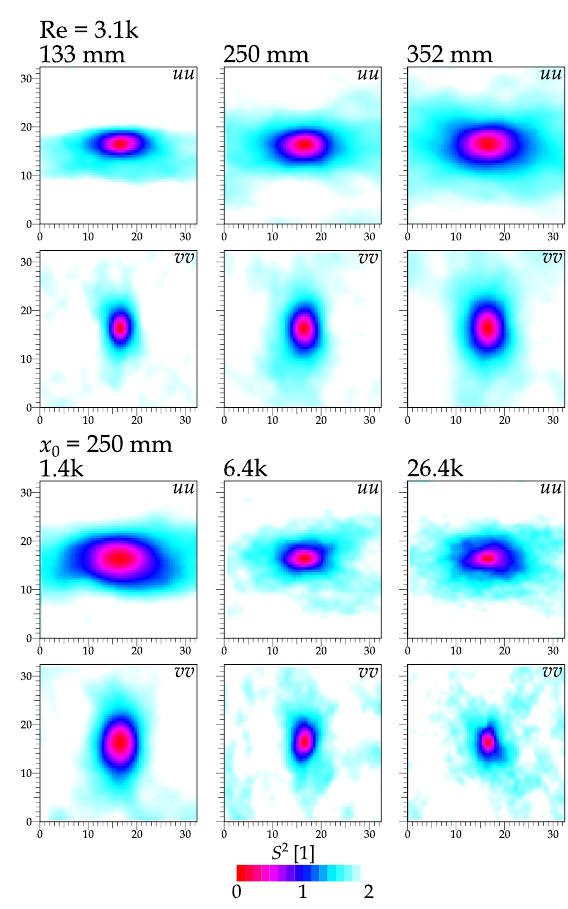
Fig. 9. Top : spatial distribution of the structure function around the point ⃗ξ in the center of the field of view in di ff erent distances from the grid. The first line shows the structure function of u , i.e. x -component of the velocity, second line does the v , which is the span-wise component. The velocity is constant corresponding to Re = 3 . 1 · 10 3 . Bottom : the distance from the grid is constant and equals to x 0 = 250mm, di ff erent panels show di ff erent Reynolds numbers.